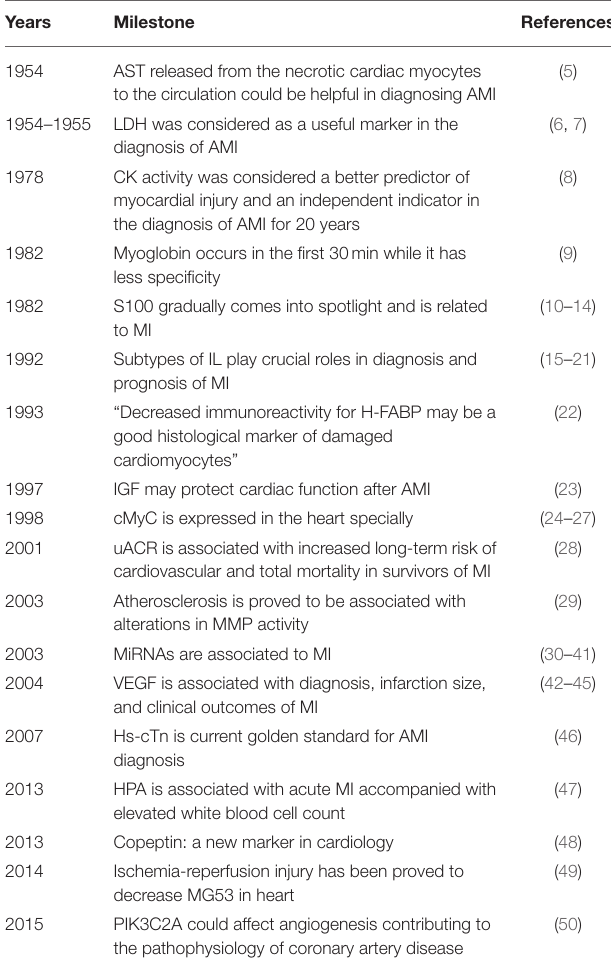
TABLE 1 | The milestones of biomarker discoveries for myocardial